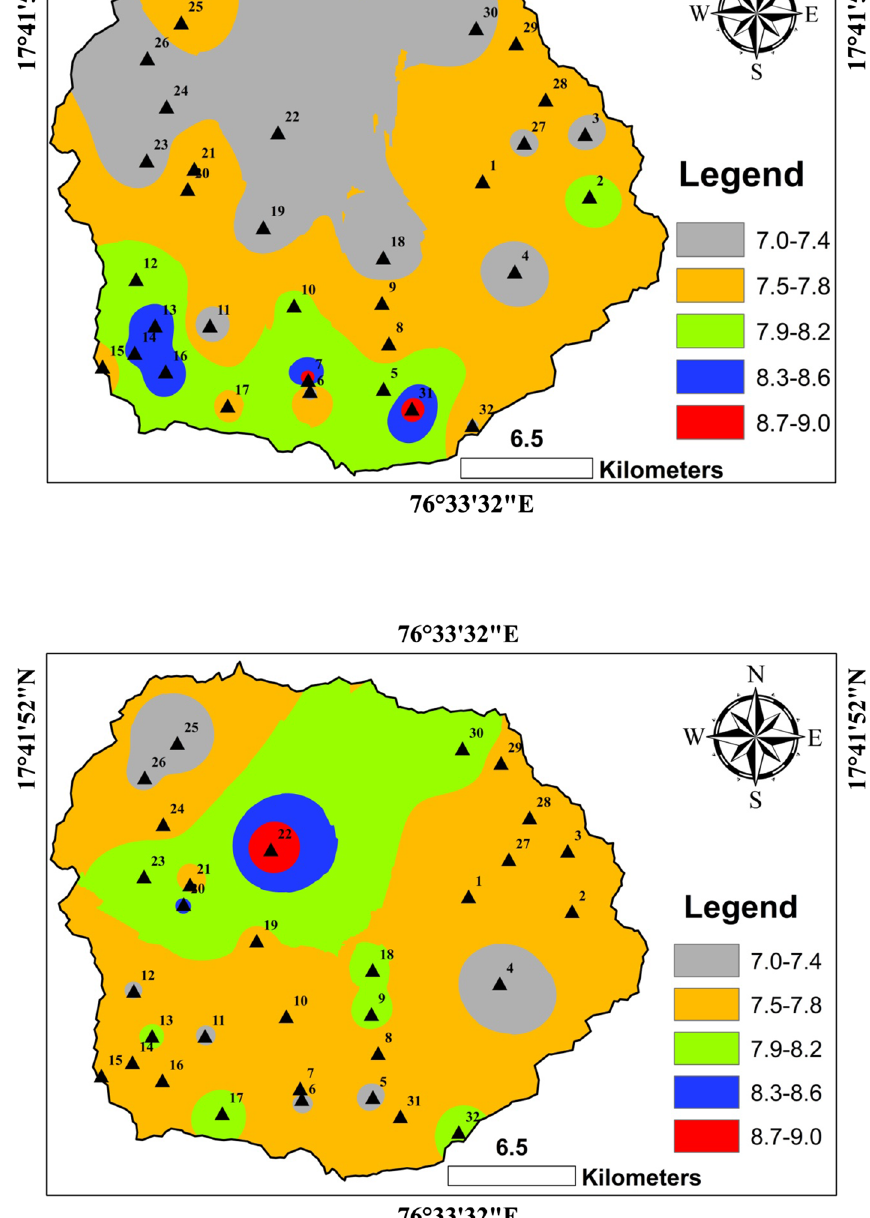
Fig. 2 Geospatial distribution of pH (pre-monsoon)